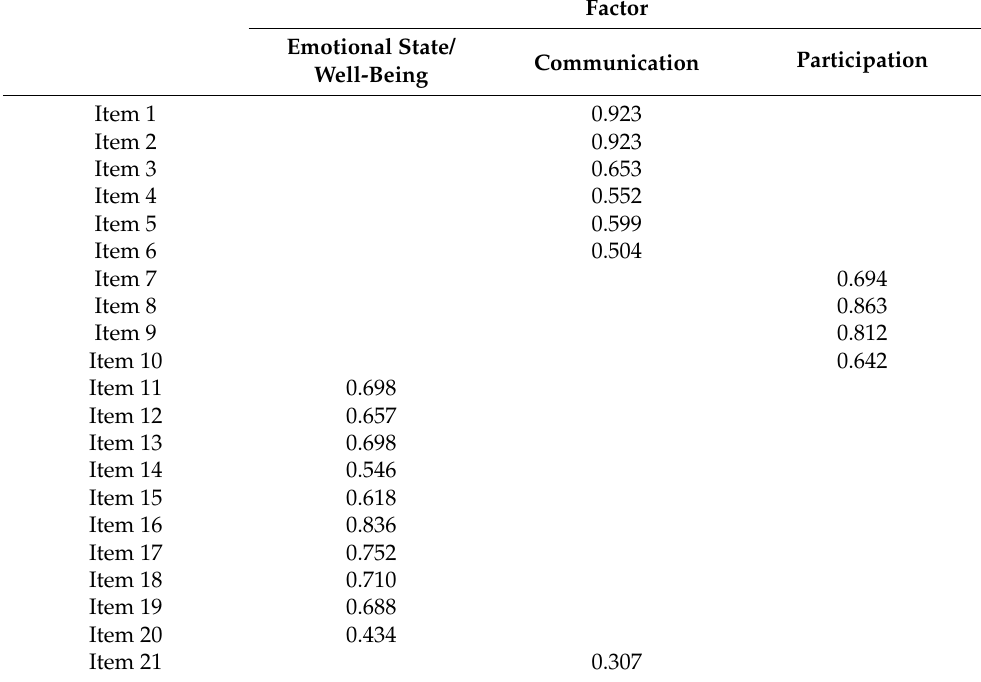
Table 7. AIQ-21-GR Factor Analysis using Maximum Likelihood estimates. Factor Emotional State/